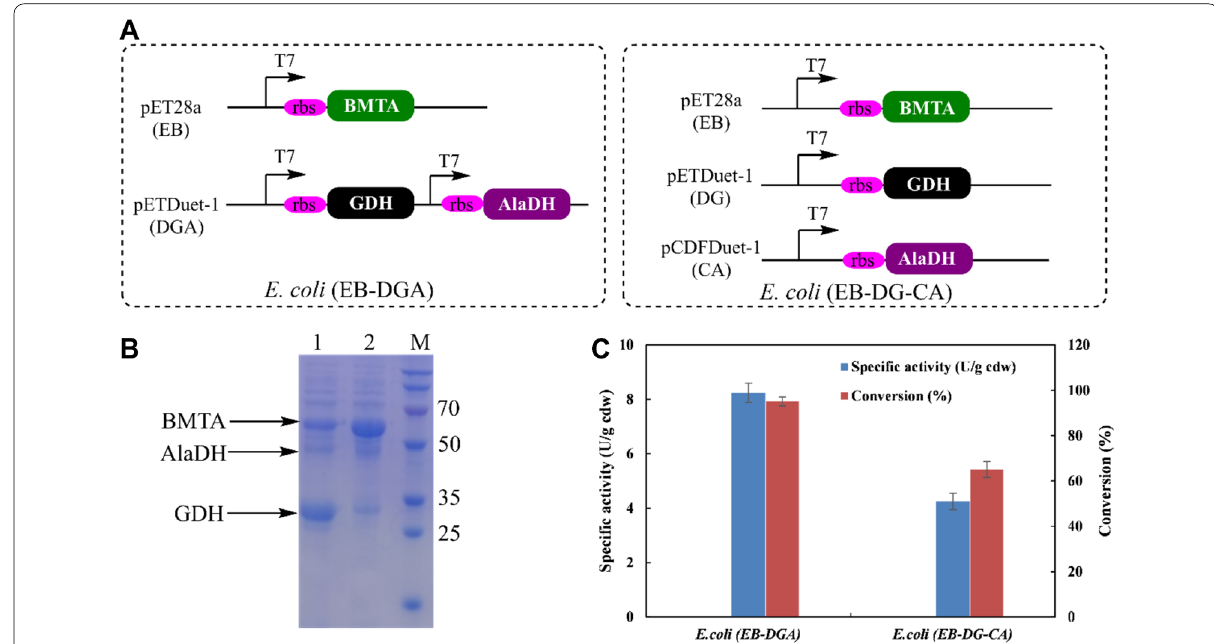
Fig. 3 Construction of recombinant E. coli cells for conversion of 2-HAP 6 to ( R )-phenylglycinol 7 . A Construction of recombinant E. coli cells co-expression of three enzymes (BMTA, AlaDH and GDH) based on different plasmid configurations. B SDS-PAGE analysis of recombinant E. coli cells. M: marker; lane 1: cell-free extract of E. coli (EB-DGA), lane 2: cell-free extract of E. coli (EB-DG-CA). C Activities of two different recombinant E. coli cells for conversion of 2-HAP 6 to ( R )-phenylglycinol